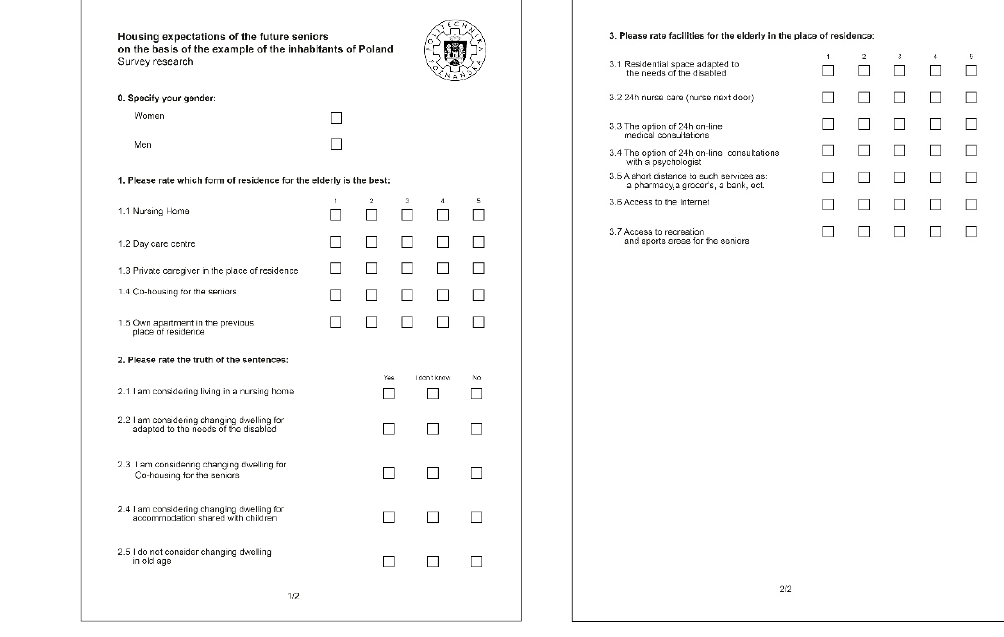
Figure 3. The original survey form. A. Skórka.